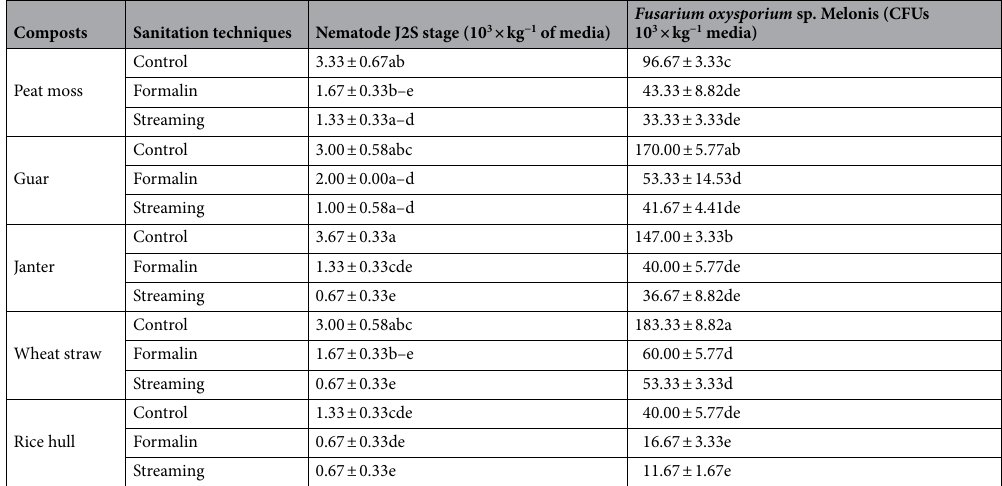
(Table 3). Similarly, spore farming units of F. oxysporium sp. melonis were quantified in the suspensions and serial dilutions 52 (Table 3). Determination of nitrifying bacteria in the composts. Composts samples were collected and brought to the laboratory under sterile conditions after 0, 10, 20 and 30 d (harvest) and abundance of nitrifying bacteria (CFUs) were determined by plating in the medium having chemical composition for all nitrifying bacteria 53 . Briefly, 1 g of the media was mixed with 30 ml using sterile water and serial dilutions of 10 −1 to 10 −5 suspensions were spread on agar media.